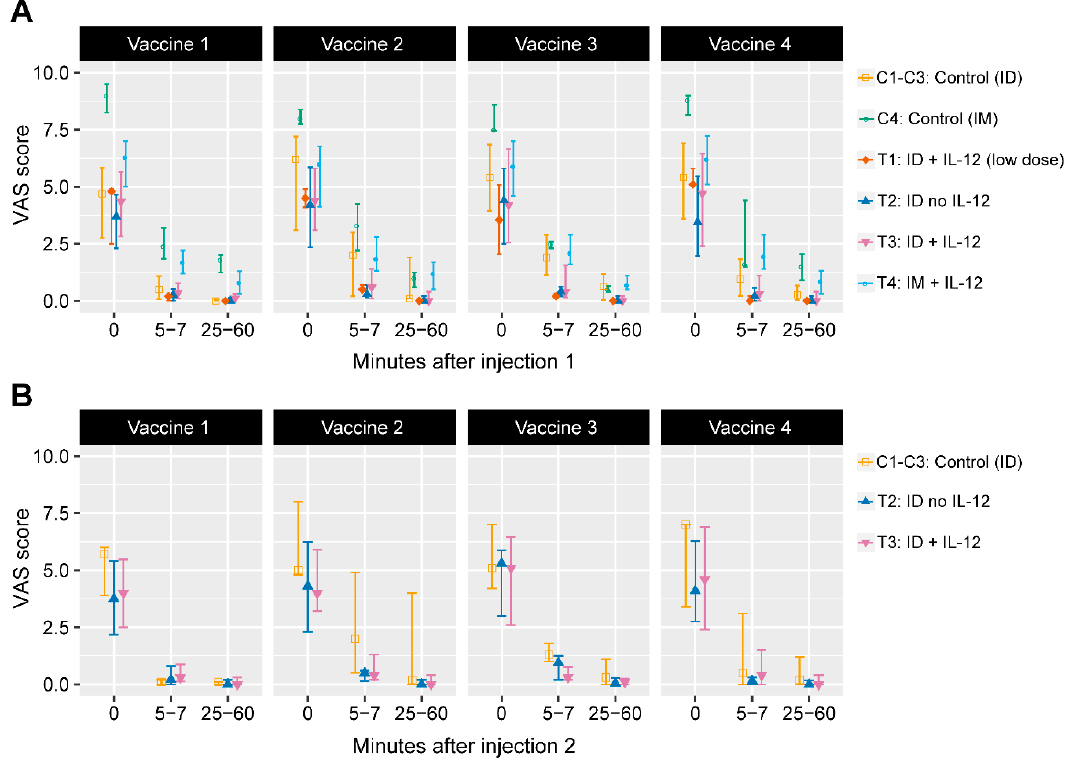
Figure 2. Distributions (median, 25th and 75th percentiles) of visual analog scale (VAS) scores by treatment group. VAS scores immediately following injection at time 0 min, 5 to 7 min later, and 25 to 60 min later at ( A ) injection 1 site, and ( B ) injection 2 site on the opposite deltoid. ID = Intradermal; IM = intramuscular. C1–C4 served as the control groups for each of the four treatment groups T1–T4.